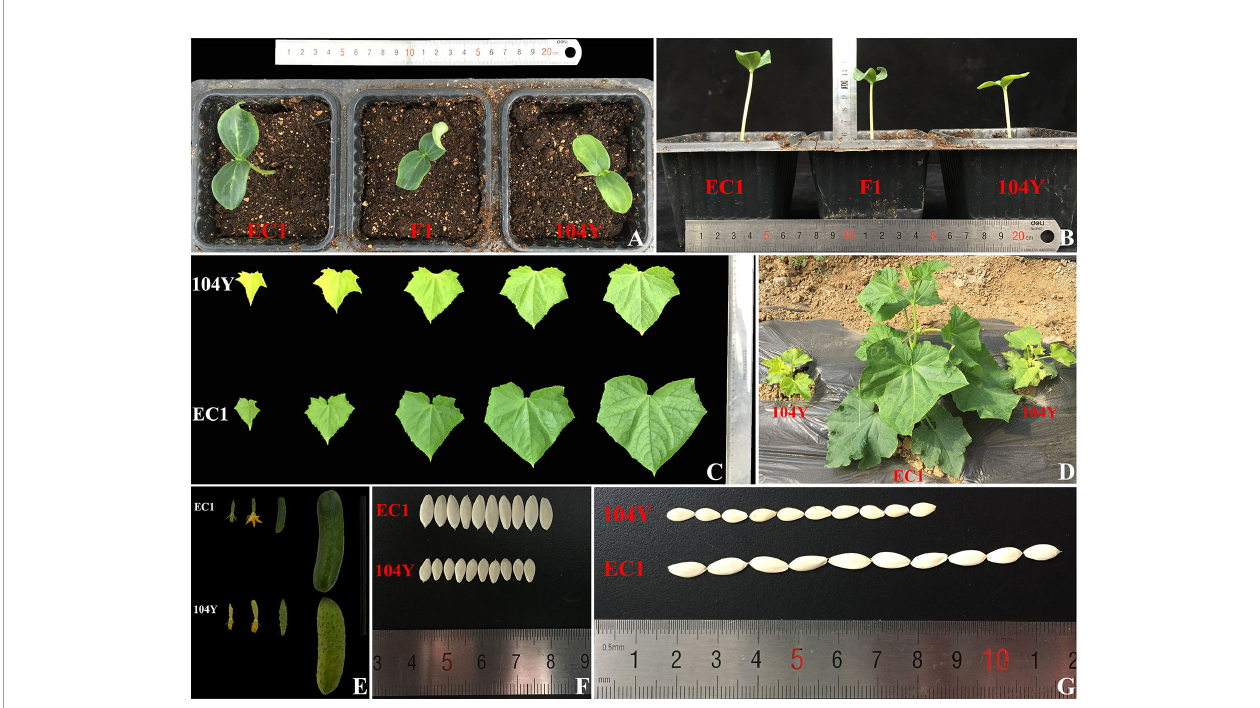
FIGURE 1 | Phenotypic characterizations of virescent leaf mutant 104Y and normal green plant EC1. (A) The cotyledon color of 104Y and EC1 in the seedling stage. (B) The hypocotyl height of 104Y and EC1 at seedling stage. (C) The color change of true leaves from the fi rst to the fi fth true leaves in the 104Y and EC1. (D) The phenotypes of 104Y and EC1 plants at adult plant stage. (E) The color change of ovaries and fruits in 104Y and EC1. (F) The seeds width of 104Y and EC1. (G) The seeds length of 104Y and EC1.